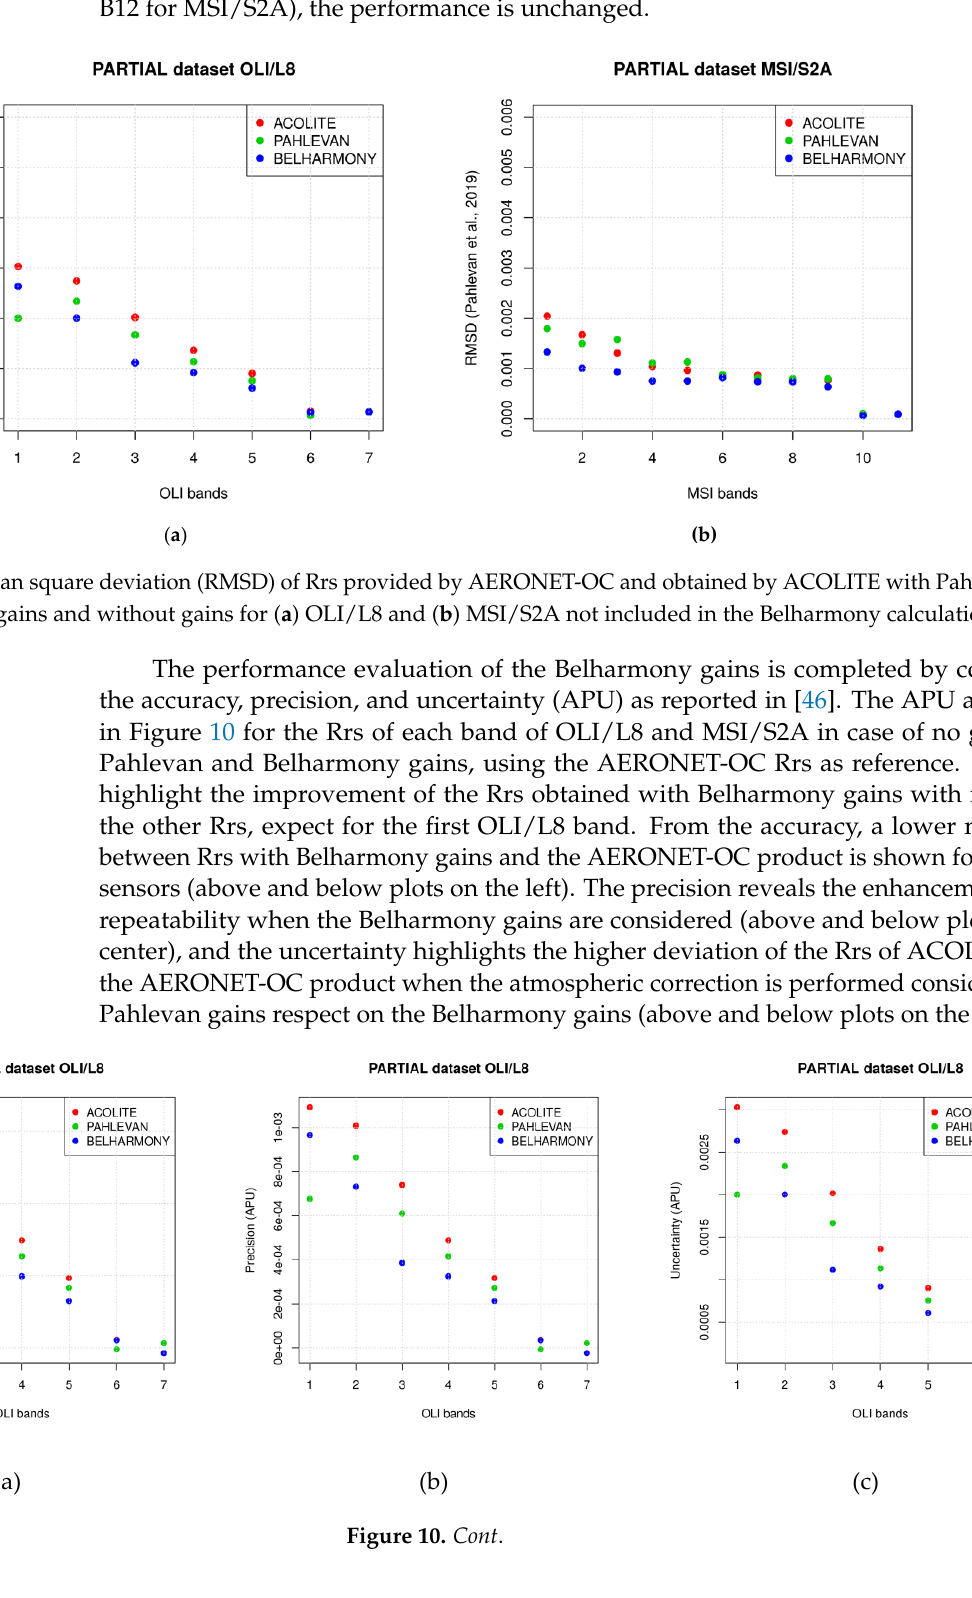
(f) Figure 10. Accuracy ( a,d ), precision ( b , e ) , and uncertainty ( c,f ) (APU) of the ACOLITE Rrs with Pahlevan and Belharmony gains and without gains for all the bands of OLI/L8 (above) and MSI/S2A (below). 5. Discussion The results show the validity of the Belharmony low-radiance gains derived in this study in terms of the Rrs obtained by the atmospheric correction of OLI/L8 and MSI/S2A data. The accurate determination of the low-radiance gains is principally addressed in this paper by the model employed to generate the simulated signal (REF), which is accurate for coastal water simulation [13], and also by the introduction of the downward diffuse component reflected diffusely towards the sensor, not considered in the model as reported in [38]. Furthermore, particular attention was paid to the sources of errors during the sim- ulation assuming a detailed depiction of atmosphere and water by the quality assured AERONET atmospheric and aquatic products [9]. The median and the standard deviation reported in Tables 3 and 4 are compliant with the accuracy of the gains over waterbodies. Indeed, the second band of both the sensors has an error of 4%, which is less than the limit (5%) desired for the blue bands over oceanic waters [13]. The gains in the other bands contain a larger uncertainty as expected for the spectral limit (700 nm) of the 6SV water modeling explained in Section 2.3.1.